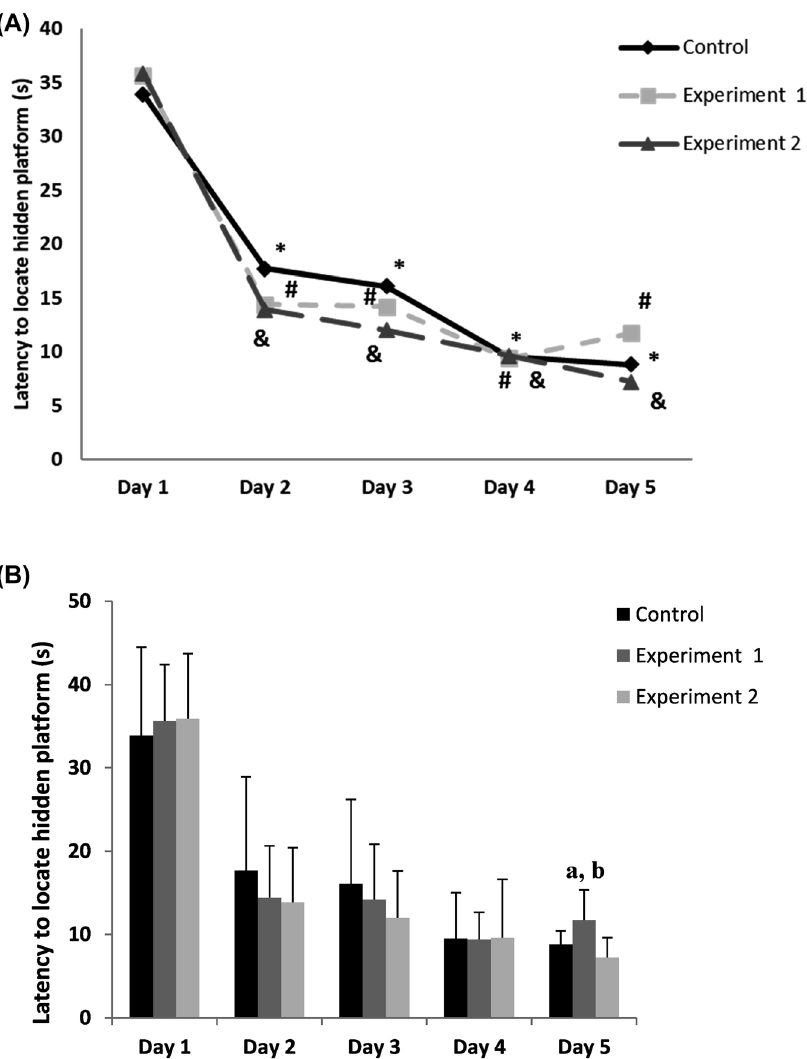
Figure 1: Comparison of latency to locate the hiddenplatformduringthetrainingperiodin Morris Water Maze. (A) Intragroup day-to- day comparison of the time to fi nd the hidden platform. * Indicates a signi fi cant di ff erence as compared to the 1st day of the control group (p<0.001); # indicates a signi fi cant di ff erence as compared to the 1st day of the Exp1G (p<0.001); & indicates a signi fi cant di ff erence as compared to the 1st day of the Exp2G (p<0.001); Exp1G, experiment 1 group; Exp2G, experiment 2 group. Data are given as mean ± SD. (B) Intergroup comparison of the time to fi nd thehiddenplatform.a,indicatesasigni fi cant di ff erence as compared to the control group (p=0.015);b,indicatesasigni fi cantdi ff erence as compared to the Exp2G (p<0.001). Data are given as mean ±